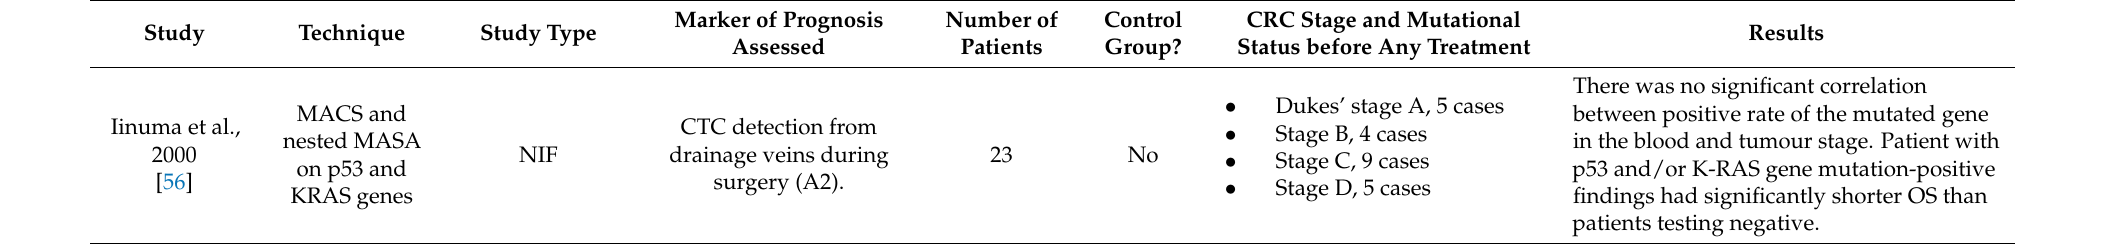
Table 4. Summary of qualitative included